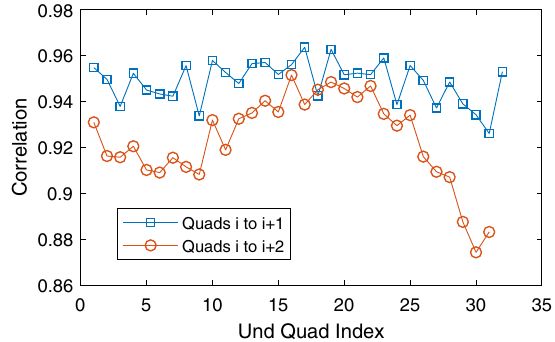
FIG. 17. Differences between fitted quadrupole gradients and the target gradients in the BSY-LTU simulation. Error bars are the standard deviation of fitting results from 10 random